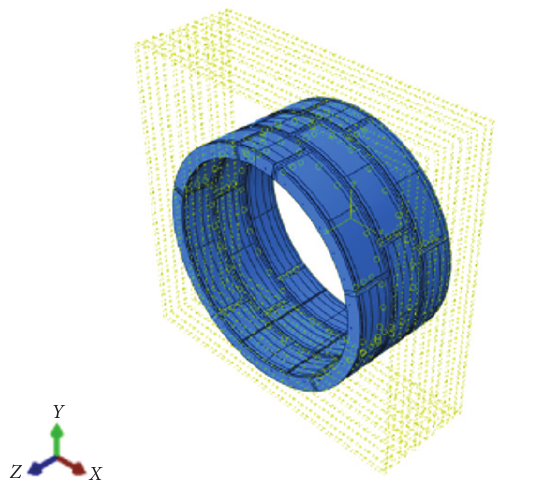
Figure 3: The overall numerical model of the shield tunnel lining